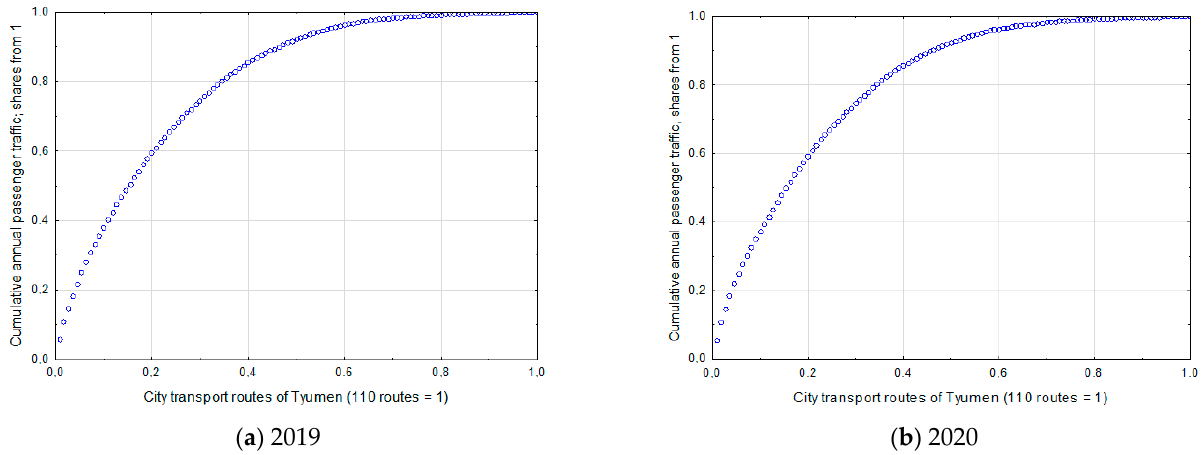
Figure 13. Pareto-distribution of cumulative annual volume of transportation Q year (12 months) at Tyumen CPPT routes. Note: scales of coordinate planes are normalized in range [0, 1].